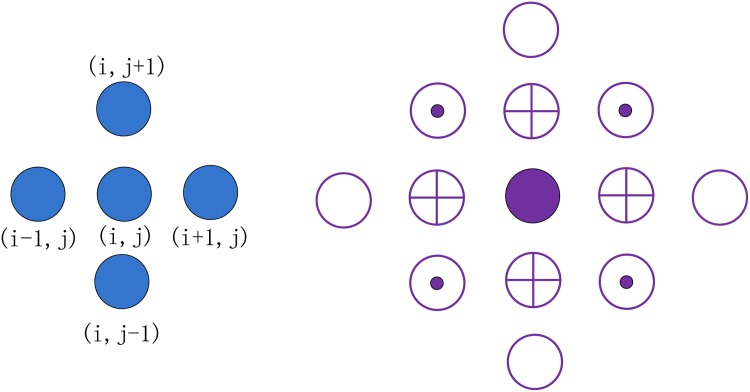
State reconstruction in cell (i, j), values in the adjacent four cells are needed (Left). The 13-point upwind stencil (Right): values of the adjacent twelve cells from different positions are needed to compute the value of the solid point in the center.